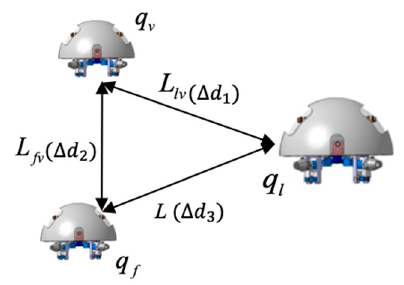
Figure 20. Relative distance between robots.